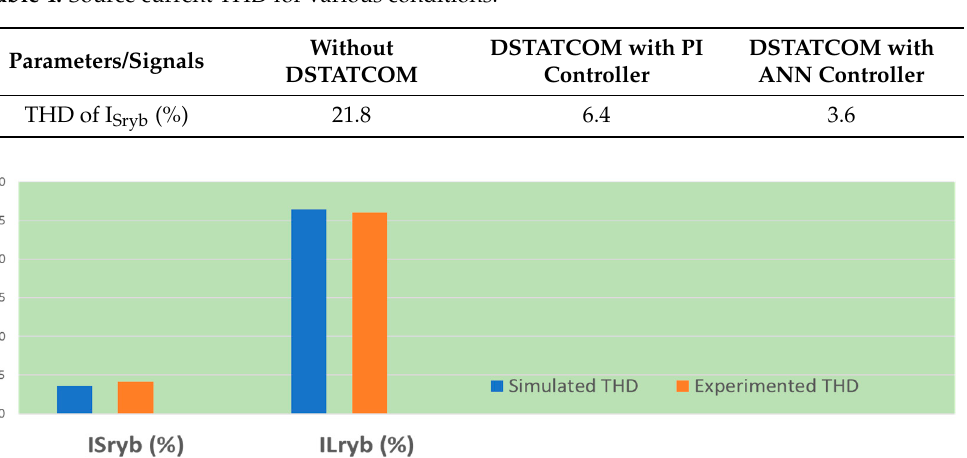
Table 3. THD of the simulated and experimented models. Table 4. Source current THD for various conditions.